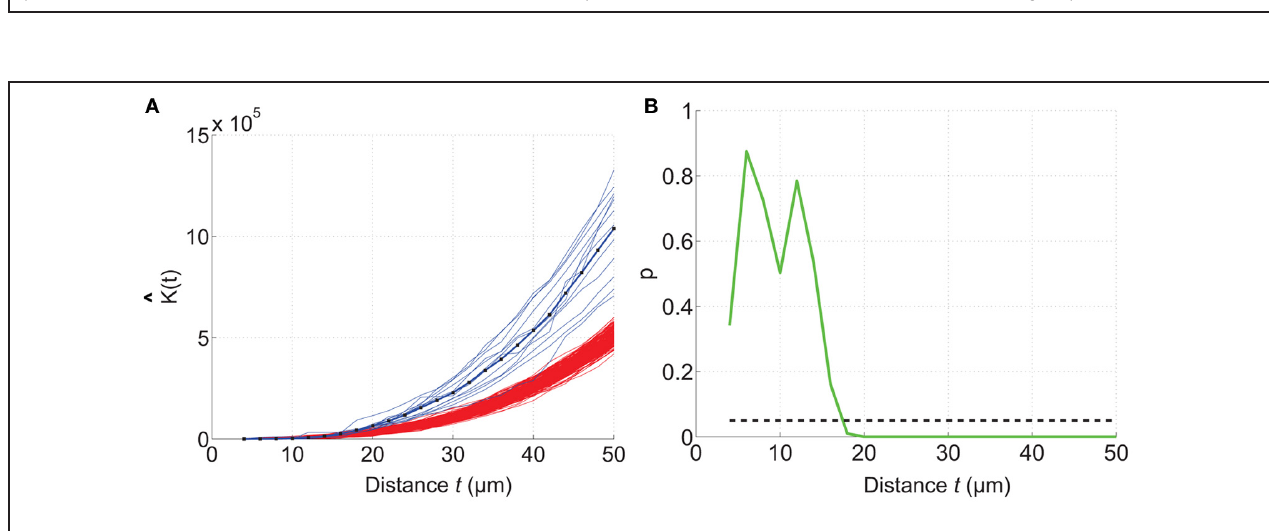
mouse cortex cut in the coronal plane. Pia matter is at y = 0, and the y-axis is distance from pia matter; x-axis is the width of the tissue slice. The six cortical layers are labeled L1 (Layer 1), etc. The black box shows the approximate position of the image in (A) and the green box the approximate position of the EGFP-labeled cells. A sub-section of the image is plotted in 3D in (C) .